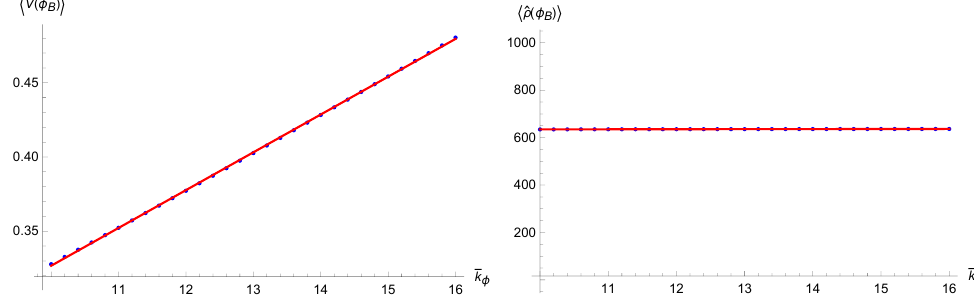
Figure 6. Expectation values of the volume ( left ) and of the density ( right ) at the time φ B of the Bounce as functions of k φ (blue dots), fitted with functions in accordance with the semiclassical evolution (full red